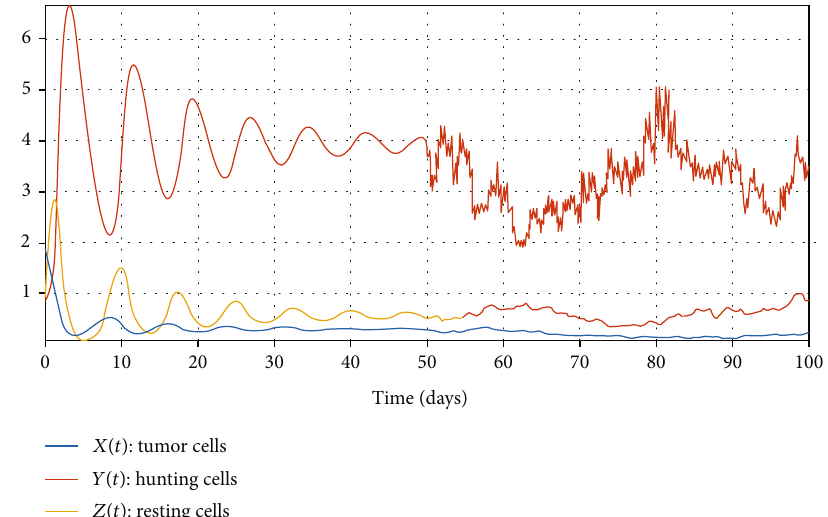
= 0 : 9 , c = 0 : 65 , c = 0 : 21 , c = 0 : 55 , c = 0 : 92 , c = 0 : 39 , c 1 2 3 4 5 6 7